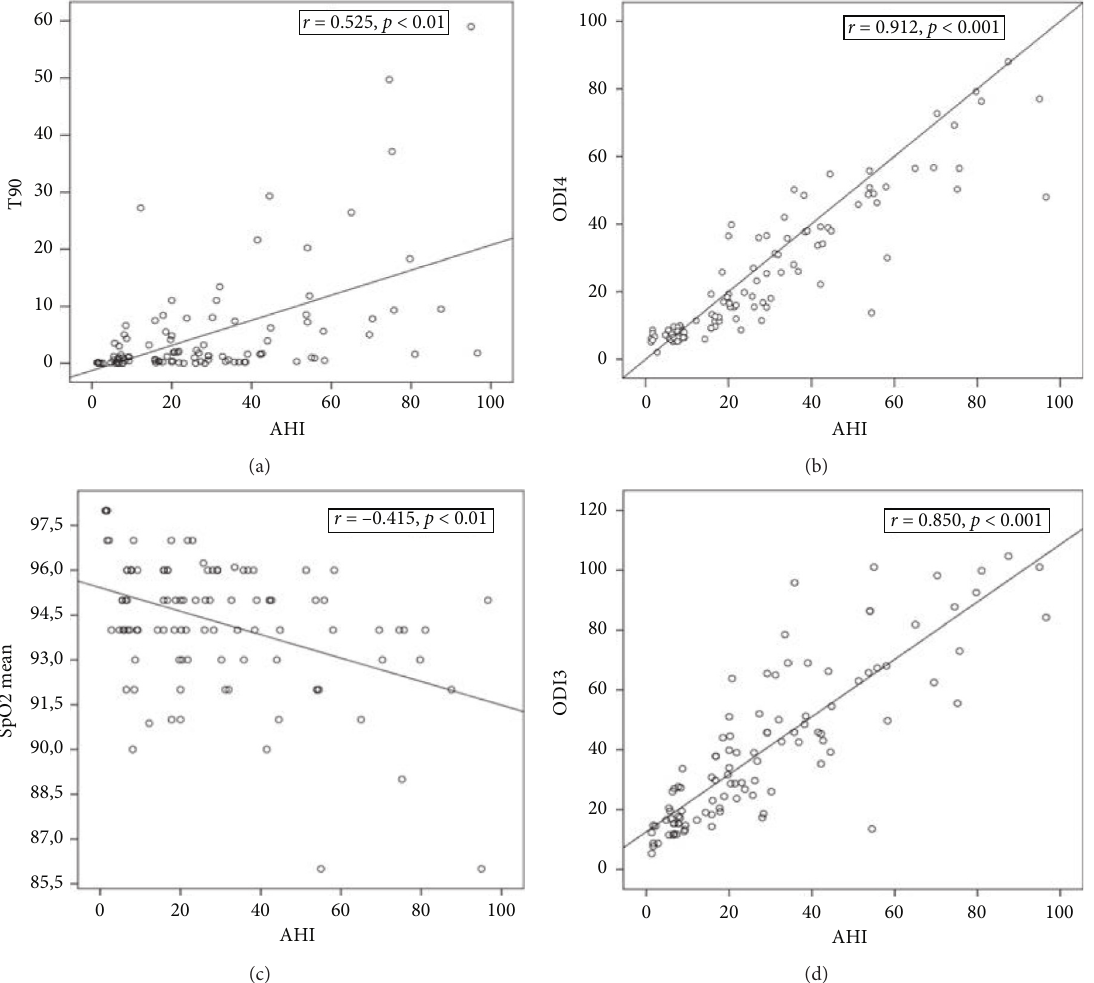
Figure 1: Correlations of apnea-hypopnea index with oxygen desaturation index and percentage of recording with SpO nocturnal oximetry. The correlation in ODI3 (good correlation, r > 0.8) and ODI4 (excellent correlation, r > 0.9) is shown. AHI: apnea- hypopnea index; ODIs: mean number of oxygen desaturations ≥ 3% and 4% (ODI3 and ODI4) per hour of recording; T90: time spent with SpO 2 <